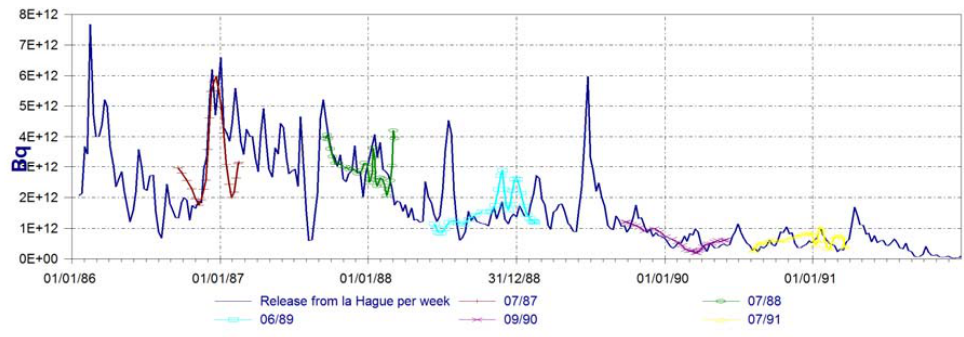
Figure 15. Quantities of 125 Sb measured in North Sea boxes during oceanographic campaigns compared to the corresponding releases from the La Hague plant, adapted from [18].